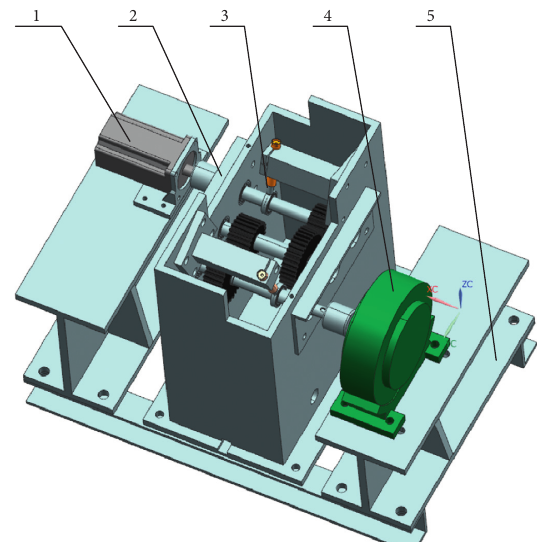
Figure 2: Gear transmission system with a built-in piezoelectric actuator. 1: motor, 2: gear box, 3: active control structure, 4: magnetic powder brake, and 5: